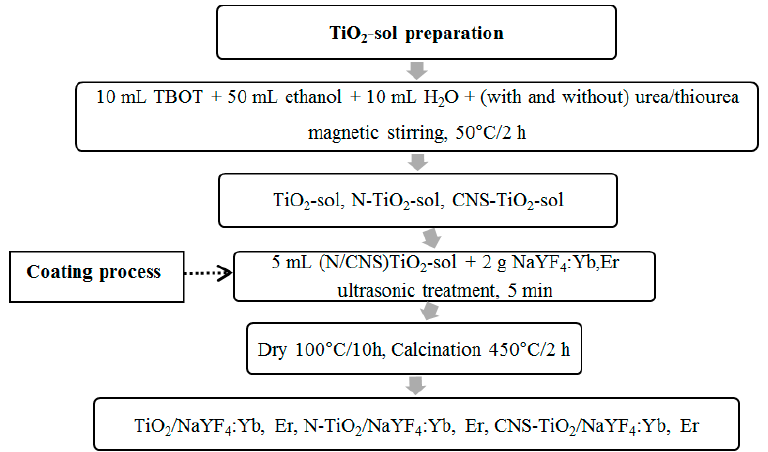
Figure 13. Flow chart of TiO 2 sol preparation and its coating process on NaYF 4 :Yb,Er.